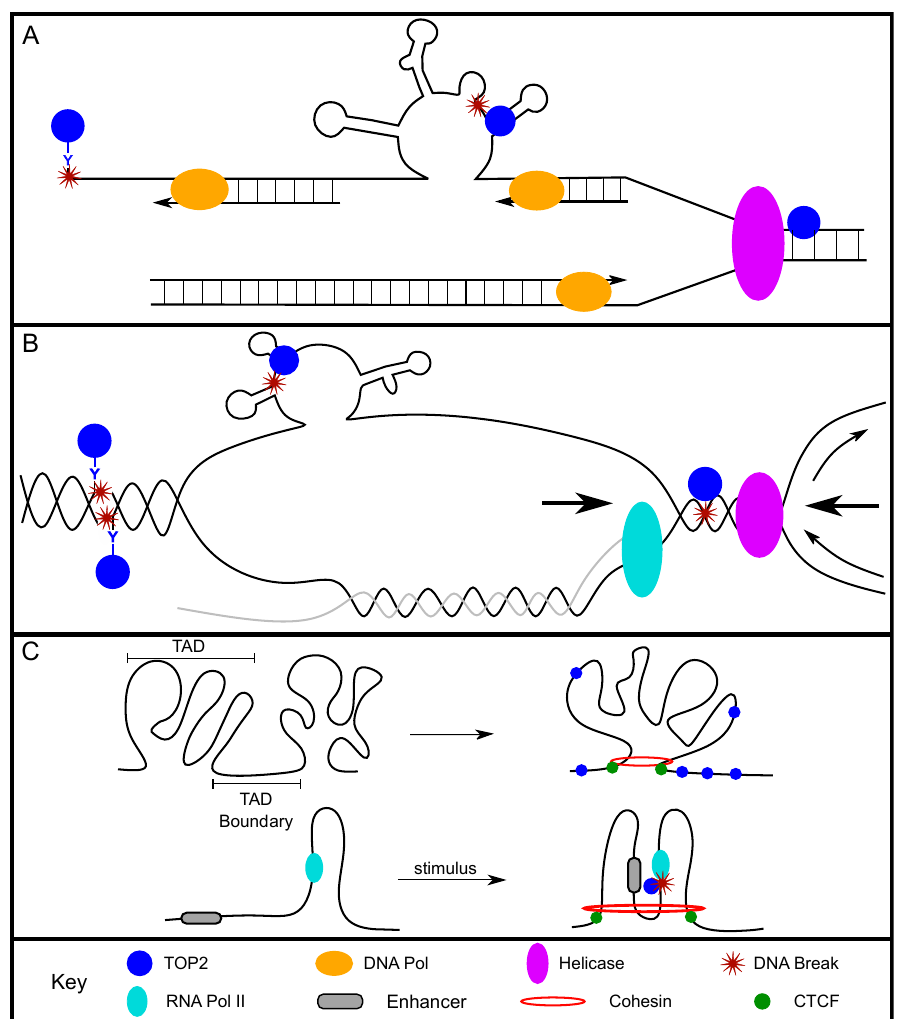
Figure 1. DNA topoisomerase II (TOP2) cleavage is required for multiple biological processes. ( A ) During DNA replication, TOP2 relieves positive supercoiling ahead of the replication fork. Single- stranded DNA on the lagging strand template can form alternative DNA secondary structures that can become targets of TOP2. Furthermore, if a TOP2 cleavage complex (TOP2cc) already exists in replicating DNA, collisions between DNA polymerase and the adduct generate DNA breaks. ( B ) During transcription, TOP2 resolves negative supercoiling behind RNA polymerase II (Pol II), which